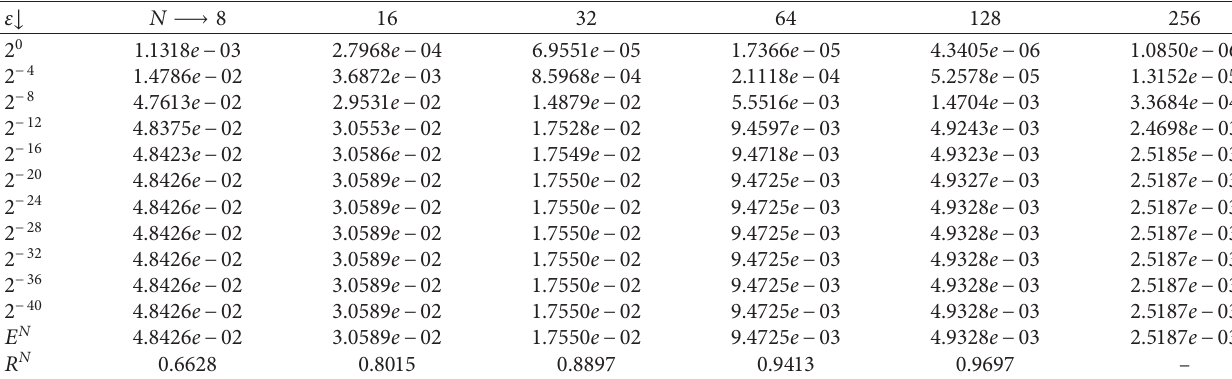
Table 5: Maximum absolute error of Example 3 before Richardson extrapolation for δ � 0 . 6 ε and η � 0 . 5 ε .